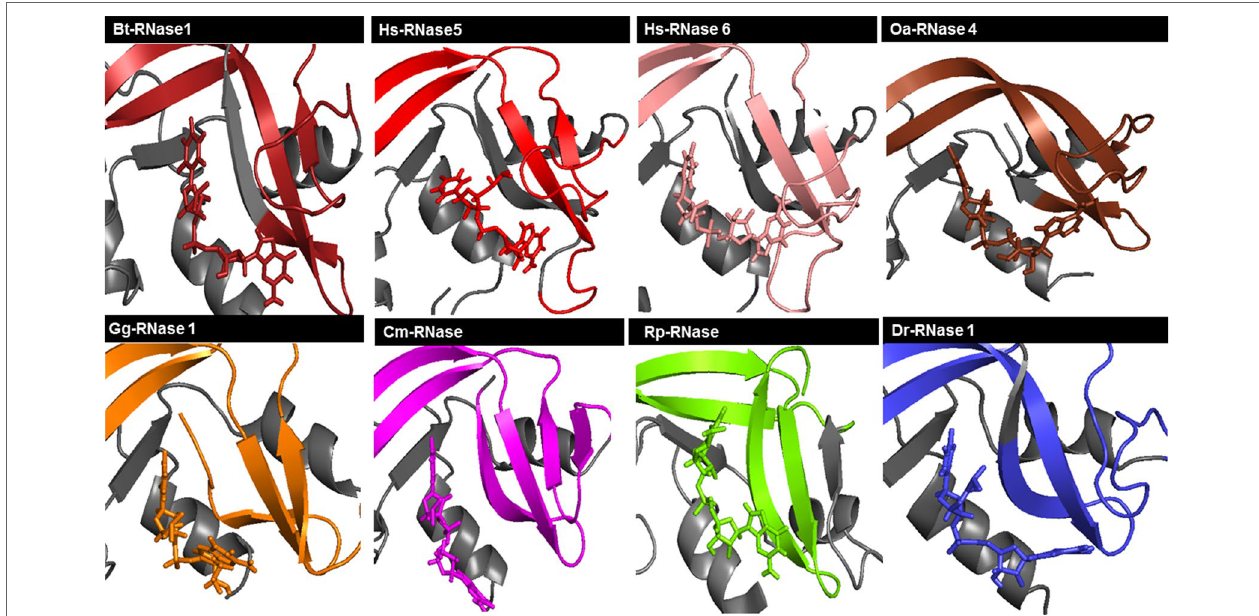
FIGURE 3 | Schematic illustration of RNase–UpA complexes obtained at the end of the MD 100 ns simulation run. Colors of each vertebrate group are taken according to the family phylogenetic tree selection (see Figure S2 ). Mammal RNases are shown in shades of red, turtle RNase in magenta, chicken RNase in orange, frog RNase in green and fish RNase in blue. Some parts of the RNase are colored in gray to allow better visualization of the ligand and the interaction regions of the protein. The picture was generated using PyMOL 1.7.2 (Schrödinger,